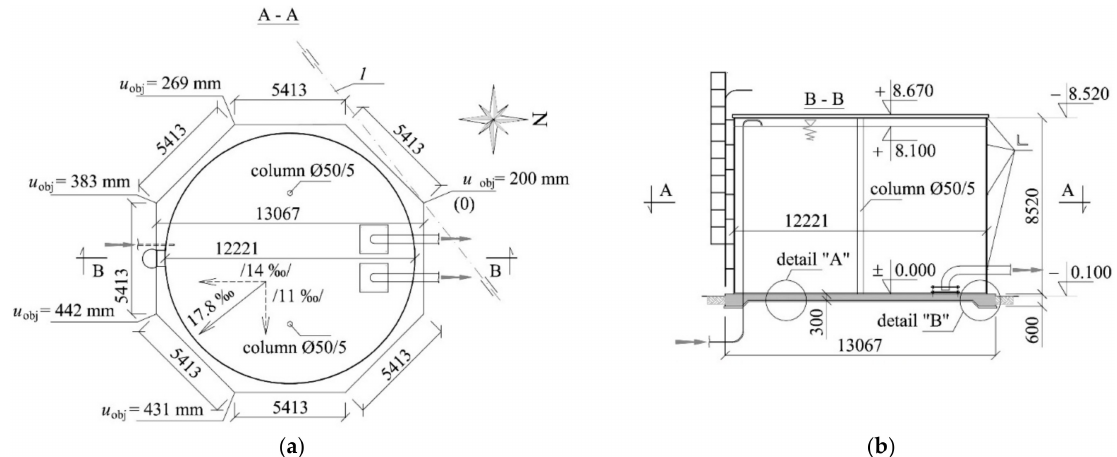
Figure 1. Tested steel water tank placed on the reinforced concrete foundation slab: ( a ) tank plan; ( b ) cross-section, 1—centre of rotation during rectification, 17.8 ‰ —resultant deflection, /14%/, /11%/—components of deflection.